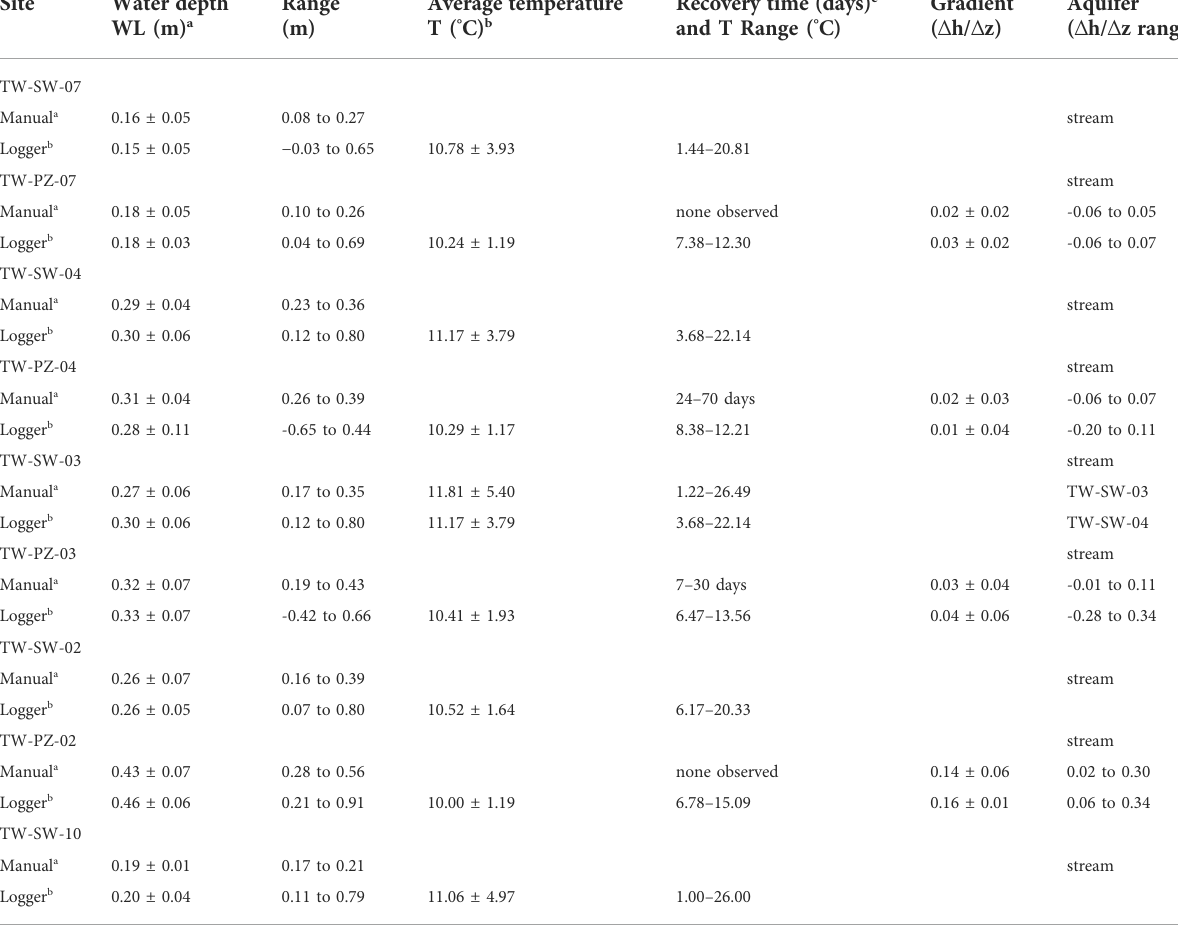
TABLE 3 Summary of pre-restoration water levels and temperatures in stream